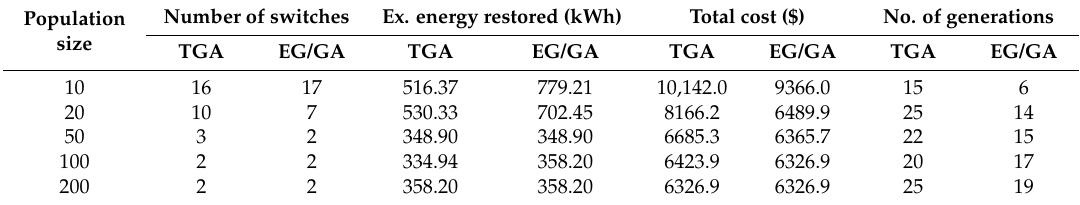
Table 4. Comparison of TGA and EG for Feeder 2.